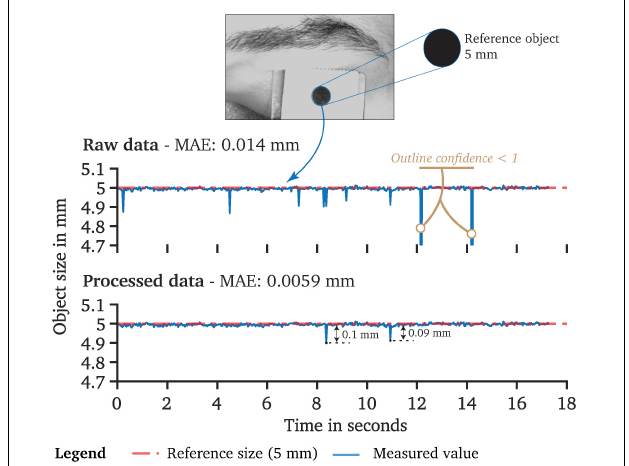
FIGURE 11 | Determination of the used stereo camera system’s measurement accuracy. A reference object of known size (5 mm) was placed in front of the observers’ occluded eye. The diameter of the object was tracked using the PuRe algorithm. Based on the raw data, a mean absolute error (MAE) of 0.014 mm can be determined. However, the raw data contain artifacts that we have removed using the proposed two-step pre-processing approach. After pre-processing, we can state a measurement accuracy of 0.0059 mm